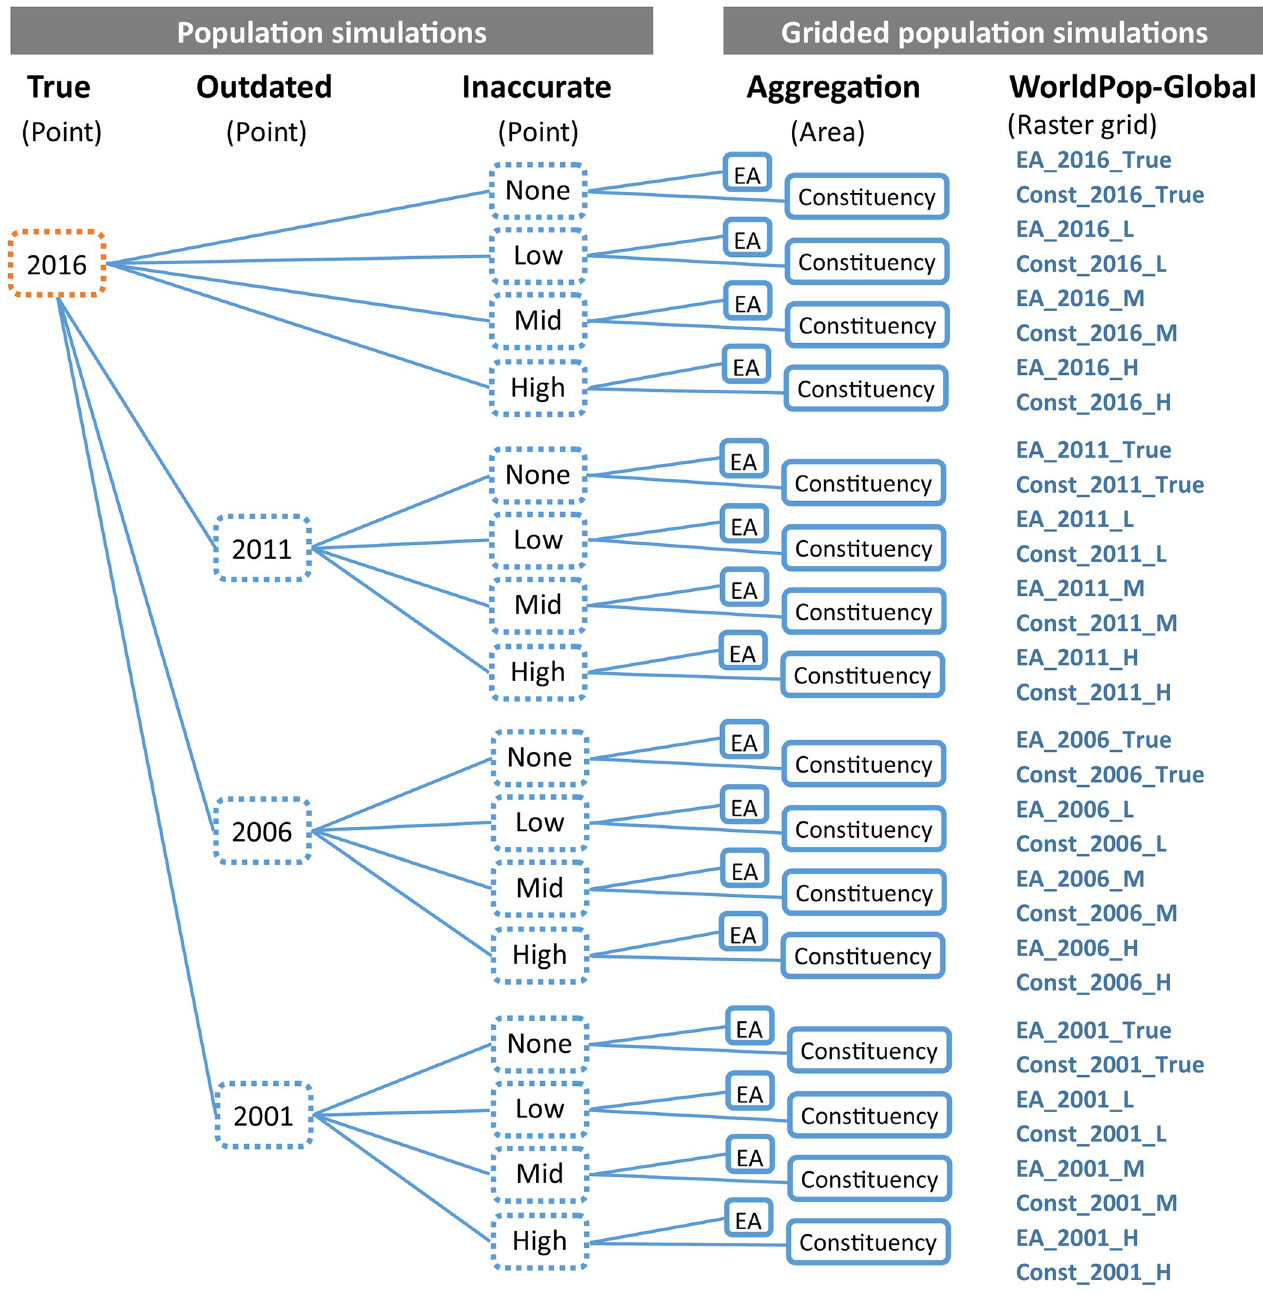
Fig 2. Summary of the population and gridded population simulation workflow. (1) Simulate a realistic population geo-located to realistic building point locations, (2) simulate three periods of outdatedness by removing households at point locations not present on satellite imagery in earlier years, (3) simulate low/middle/high census inaccuracy by removing points at random from rural, urban-slum, and urban-non-slum household types, (4) aggregate to 922 census enumeration areas (EAs) and 10 constituencies (admin-2), (5) generate 100x100m gridded population datasets in raster grid format using WorldPop-Global- Unconstrained approach and WorldPop-Global spatial